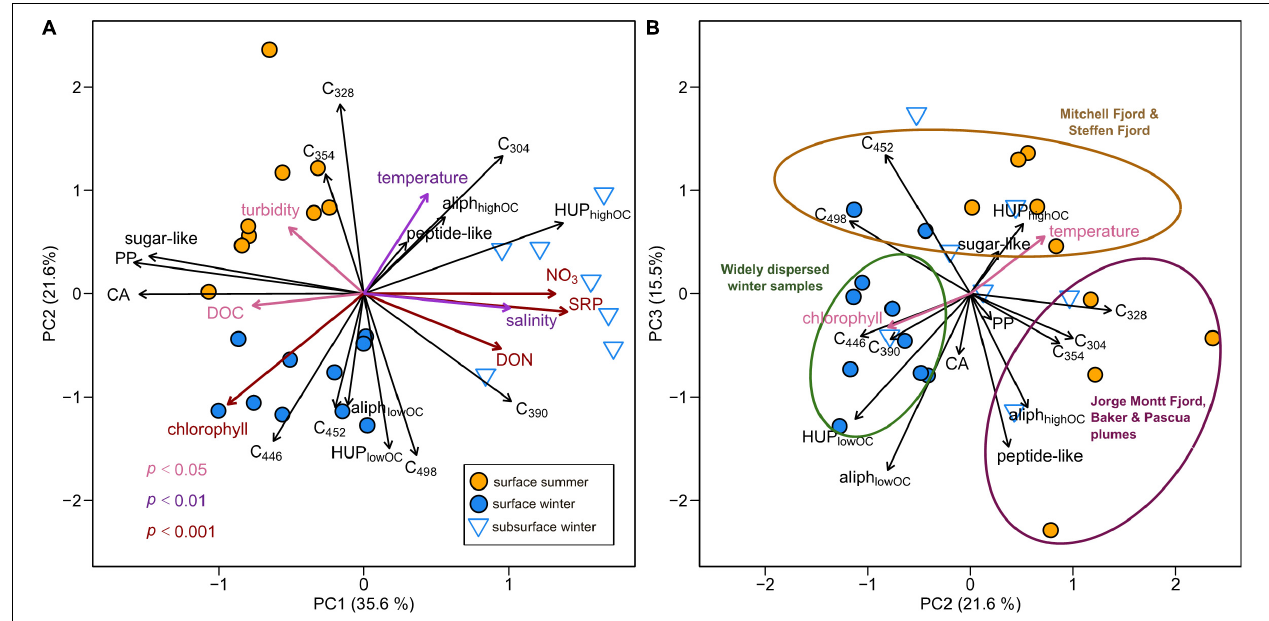
FIGURE 6 | Principal components analysis (PCA) of DOM composition in Baker-Martinez Fjord showing variations with respect to the (A) first and second, and (B) second and third principal components. PCA based on relative variations in fluorescence (PARAFAC loadings;%) and molecular composition (FT-ICR MS compound category relative intensities;%) across surface layer samples in summer and winter and subsurface waters in winter. Black arrows show loadings of variables used in PCA (refer to main text for explanation of abbreviations). Colored arrows show correlated environmental variables fit by permutation (color denotes significance level; see key on sub-panel A